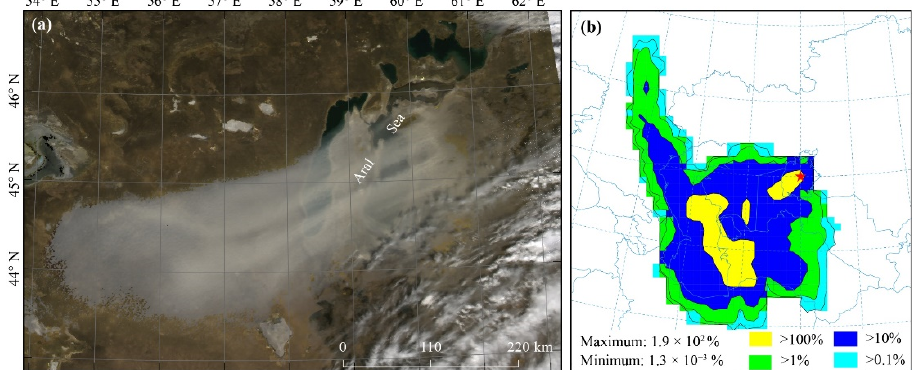
Figure 8. Sand and dust storm that occurred on 29 April 2008 captured by MODIS ( a ) and potential long-range transport of the atmospheric aerosols from the Aral Sea Basin, derived from HYSPLIT model ( b ).